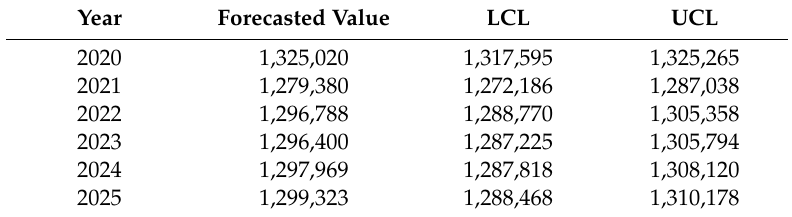
Table 1. Forecasted values of generation of organic waste in Albania with 95% confidence level